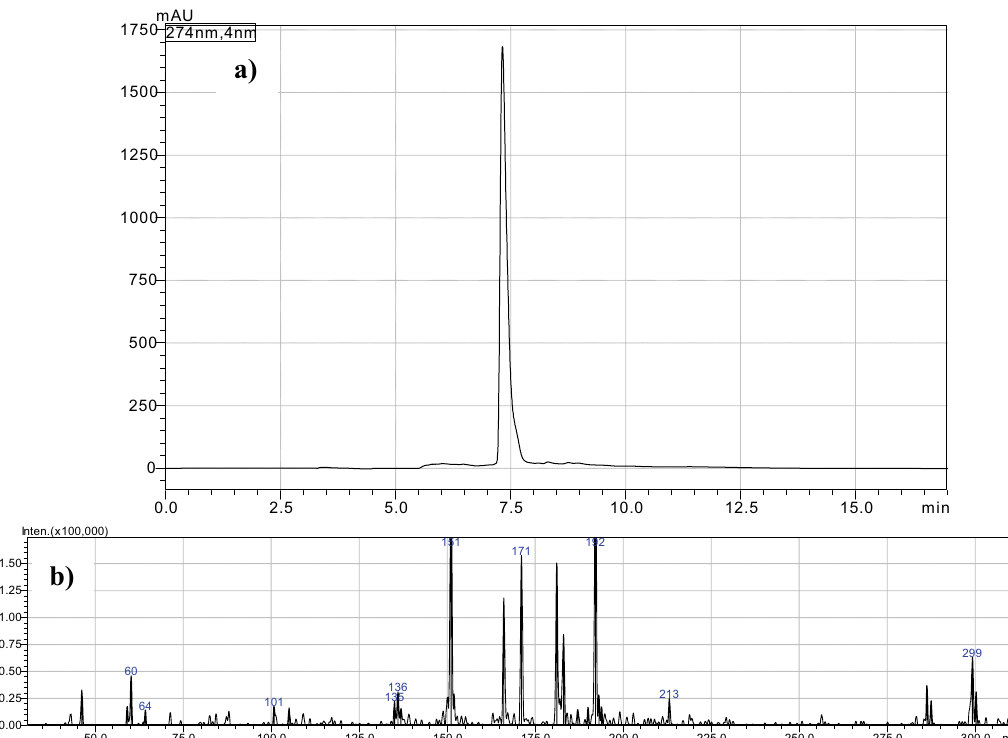
Figure 2. The chromatogram obtained by RP-UHPLC for the essential oil obtained from S. hortensis heated for 2.5 h at 190 ºC (SHEO190-2.5), (a) , and mass spectrum recorded for the compound found at 7.32 min (b) .